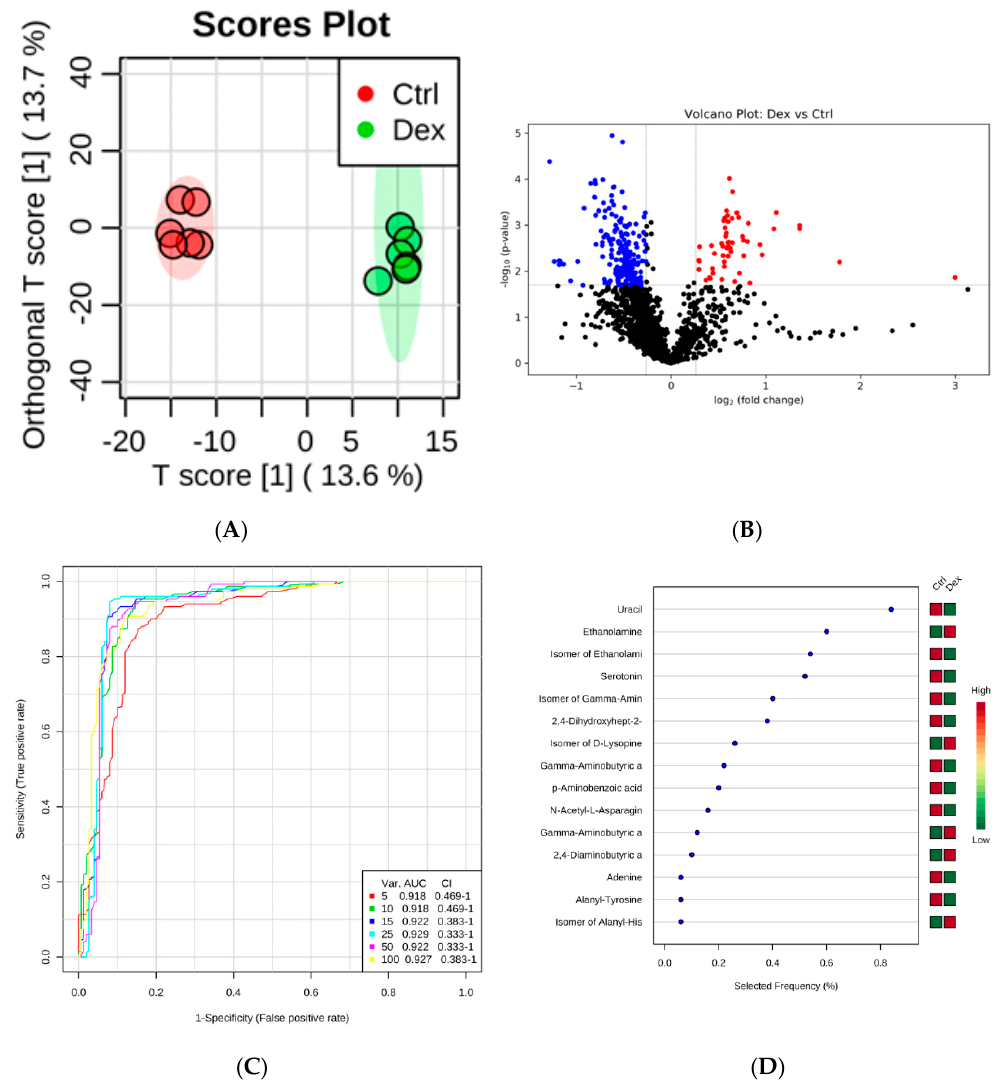
Figure 4. Rat liver tissue submetabolomic profile after prolonged treatment with dexamethasone (Dex). ( A ) OPLS-DA score plot ( Q 2 = 0.836, R 2 = 0.991) shows a clear separation between the control group (Ctrl, n = 4) and Dex-treated groups ( n = 4). Tissue samples were run on LC-MS in duplicate. ( B ) Volcano plot shows the statistically significant altered metabolites filtered with q-value < 0.05, and FC > 1.2 or < 0.83. The levels of 245 metabolites were down-regulated (blue) and 55 were up-regulated (red) in Dex-treated rats compared to controls. ( C ) The ROC curve was generated by the OPLS-DA model, with AUC values calculated from the combination of 5, 10, 15, 25, 50, and 100 metabolites. ( D ) Frequency plot shows 15 positively identified metabolites.